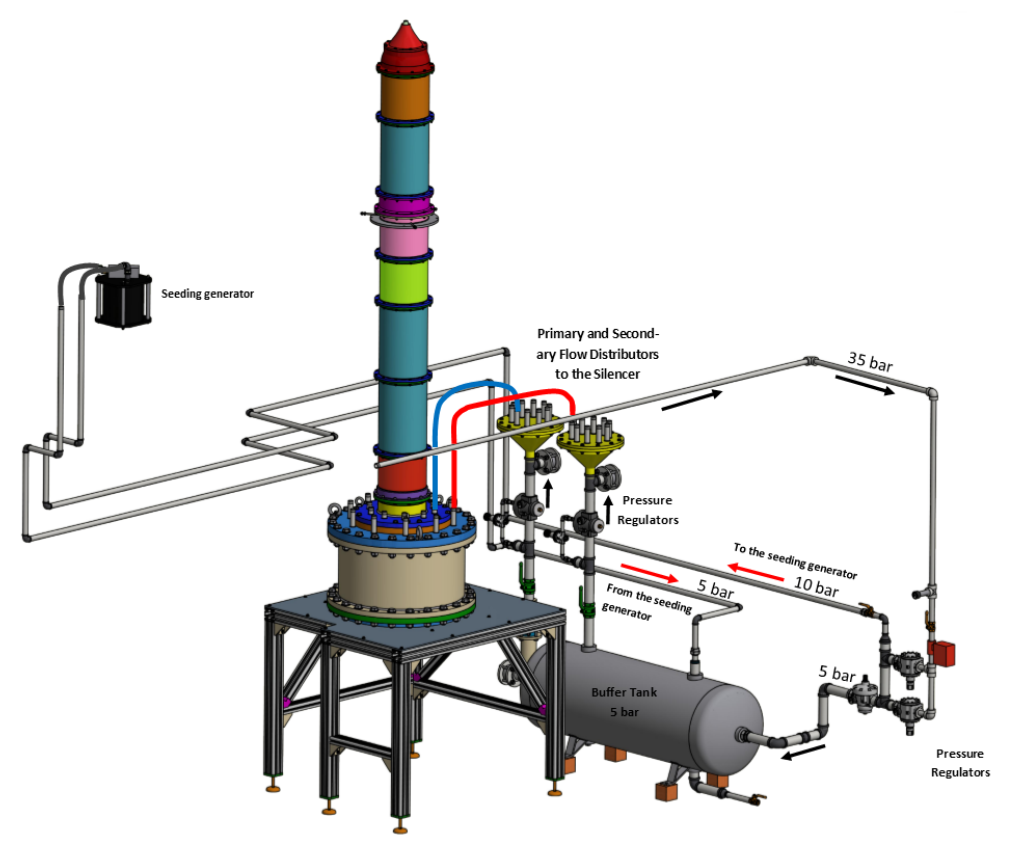
Figure 2. CAD drawing of the air supply